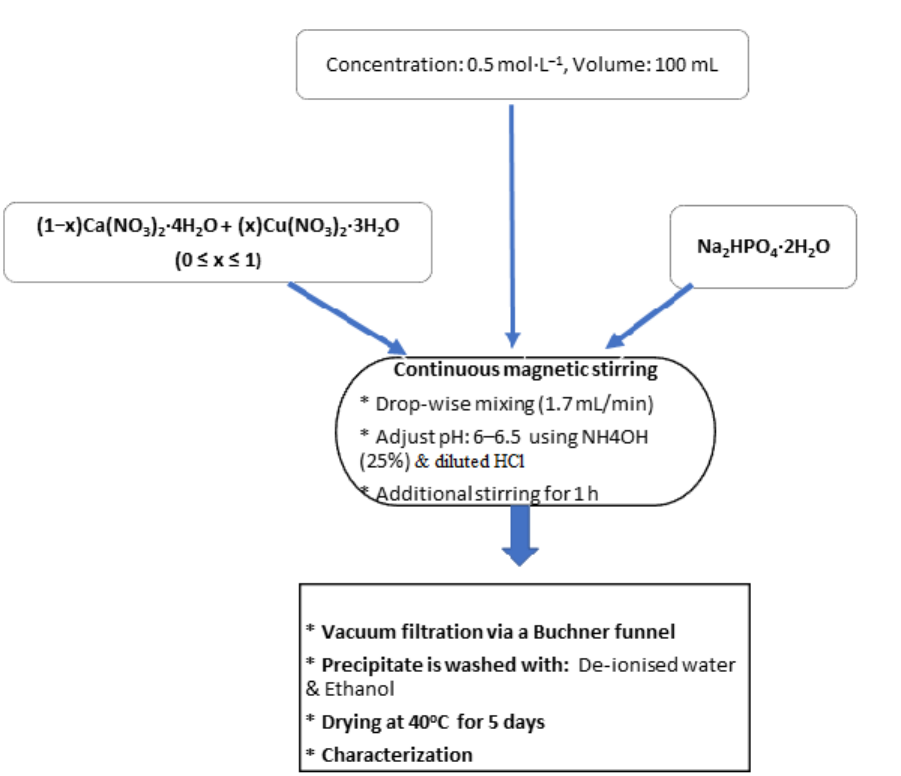
Figure 1. Preparation of calcium–copper phosphates.